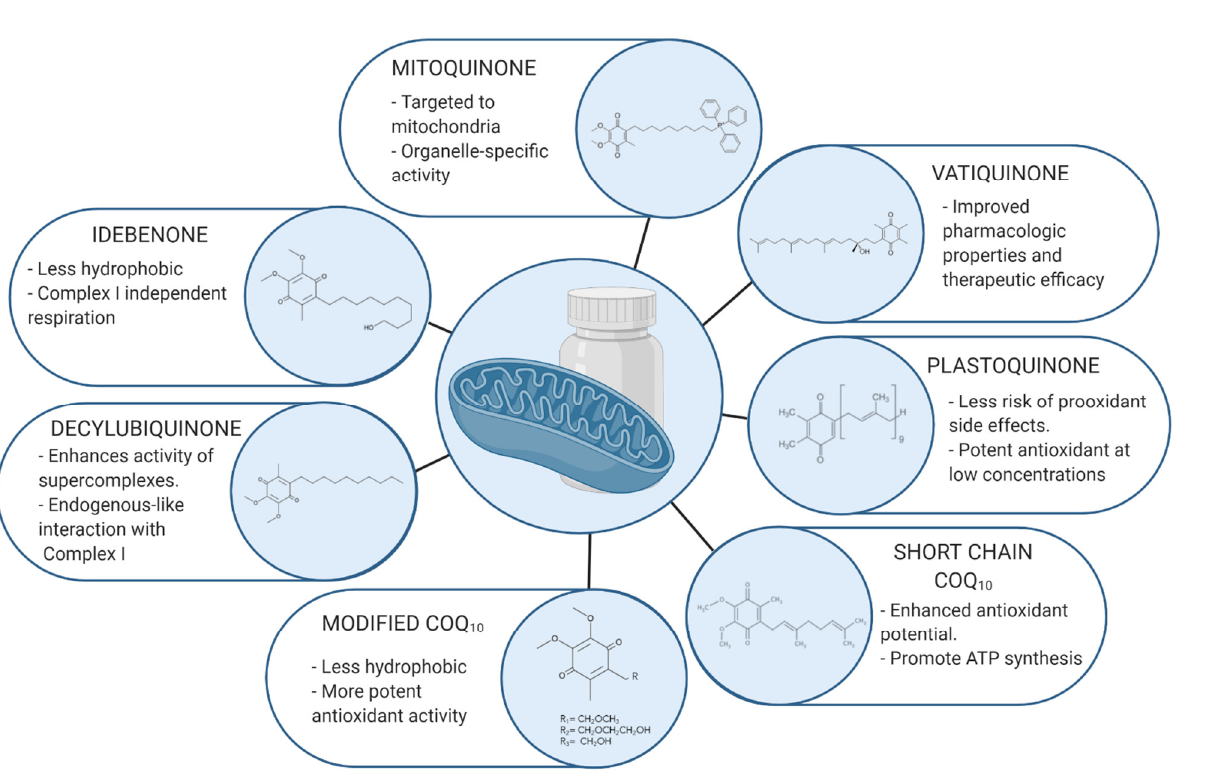
Figure 1. Molecular representation of CoQ 10 analogues. The quinone ring is known to exert the main antioxidant effect of the molecule, whereas the isoprenoid chain is able to modify the lipophilicity/hydrophilicity ratio. By altering or adding new radicals to both structures we are able to develop new treatments in order to improve specificity and functional properties.